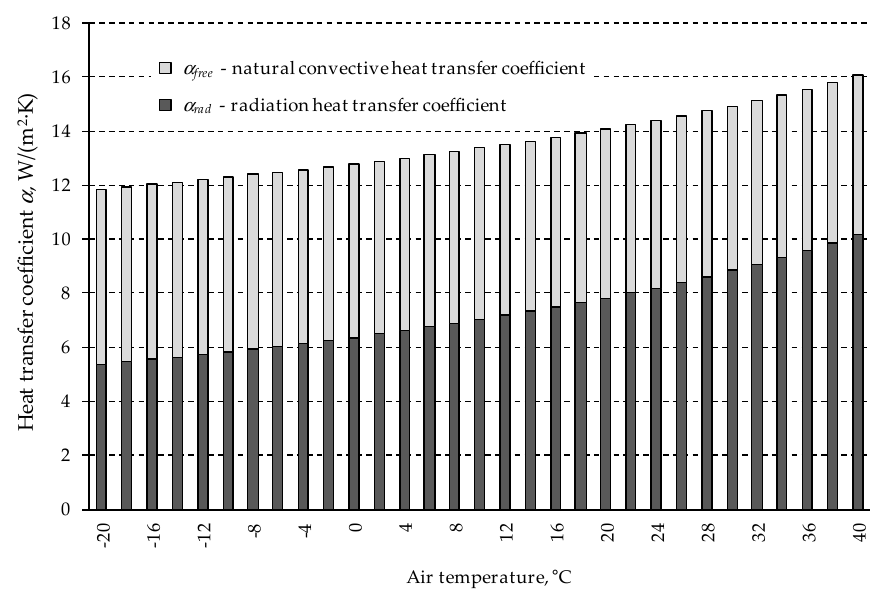
Figure 3. Relationship between the temperature (without the wind and heat transfer coefficient to air α).